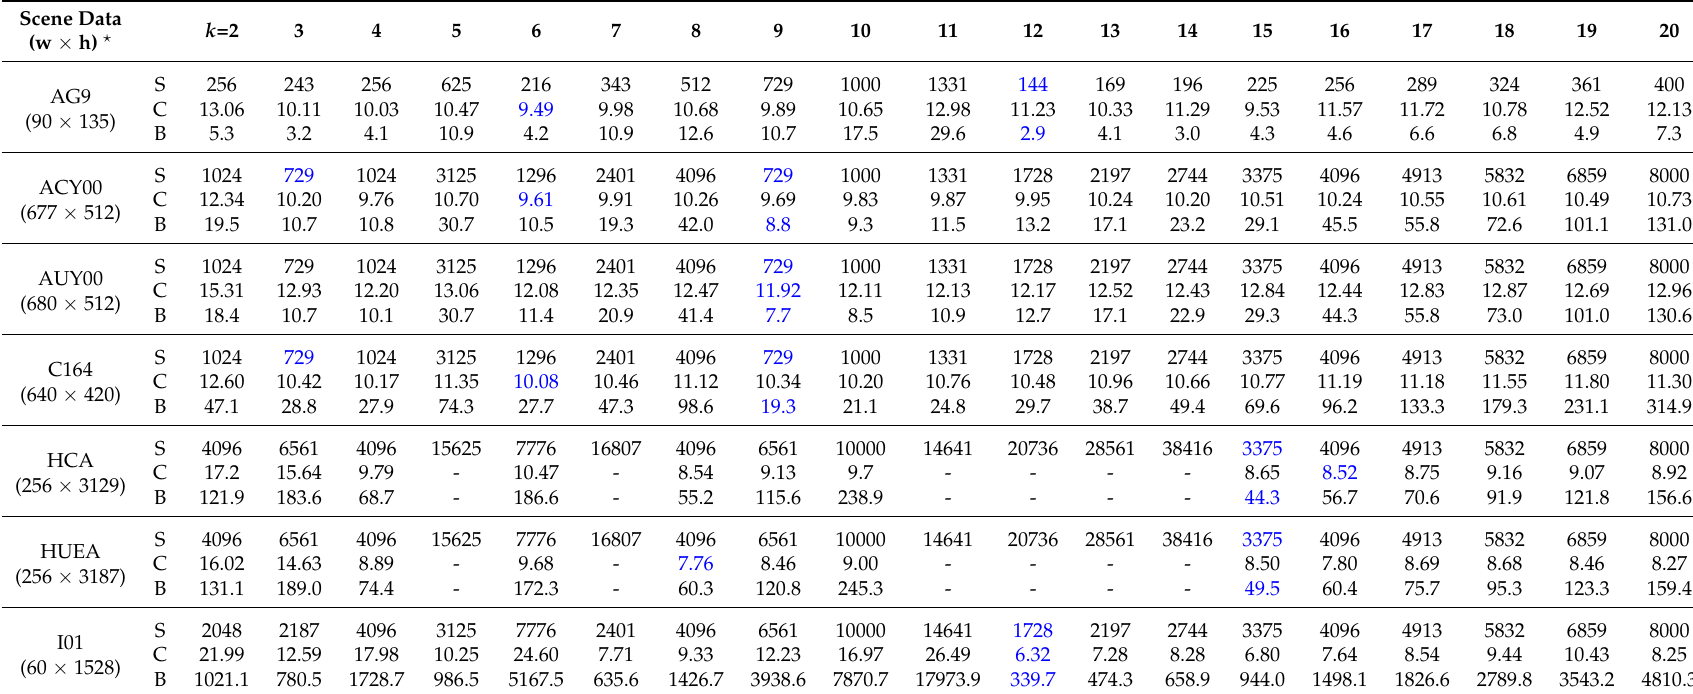
Table 9. Results for different k values using the scene data from each sensor for the following attributes: (S) the extended matrix Size (pixels), (C) the k 2 -raster Compressed storage data rate (bpppb), and (B) the time to Build the k 2 -raster (seconds). The original scene width and height are shown in the first column. The best results are highlighted in